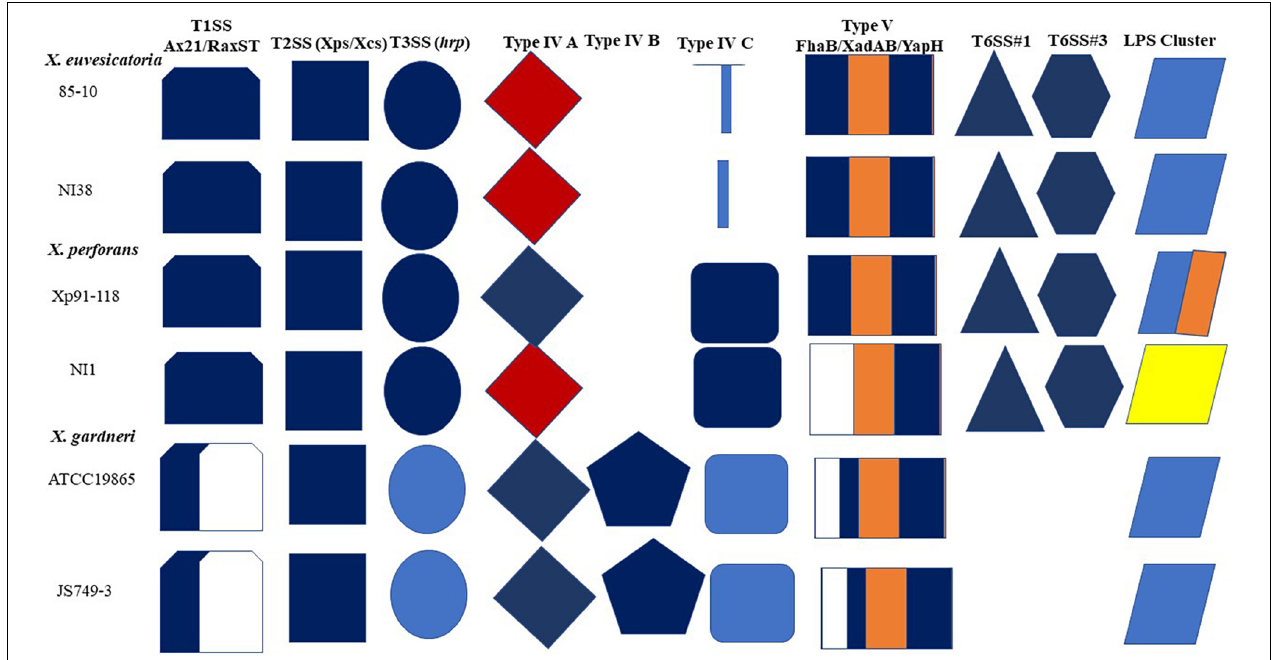
FIGURE 4 | A diagrammatic representation of secretion systems and LPS clusters in reference strains compared with sequenced African strains. Shapes and color codes follow methodology of Potnis et al. (2011) with modifications. For T1SS, dark blue color in shape shows presence of homologs of Ax21 and RaxST; white space indicates absence of RaxST. T2SS systems show presence of both Xps and Xcs systems in reference strains and African strains. T3SS shows similarity in hrp cluster. Unique X. gardneri hrp cluster is in faint blue. Type IVA shows Dot/Icm cluster in red and Vir system in deep blue. Unique type IVB cluster in X. gardneri is also shown, whereas type IVC is shown. T5SS shows that NI1 lacks homologs of genes encoding FhaB protein, whereas one copy is present in X. gardneri. X. gardneri lacks T6SS. LPS cluster of NI1 is most unique and is similar to that of X. translucence pv. translucence (Jibrin et al.,